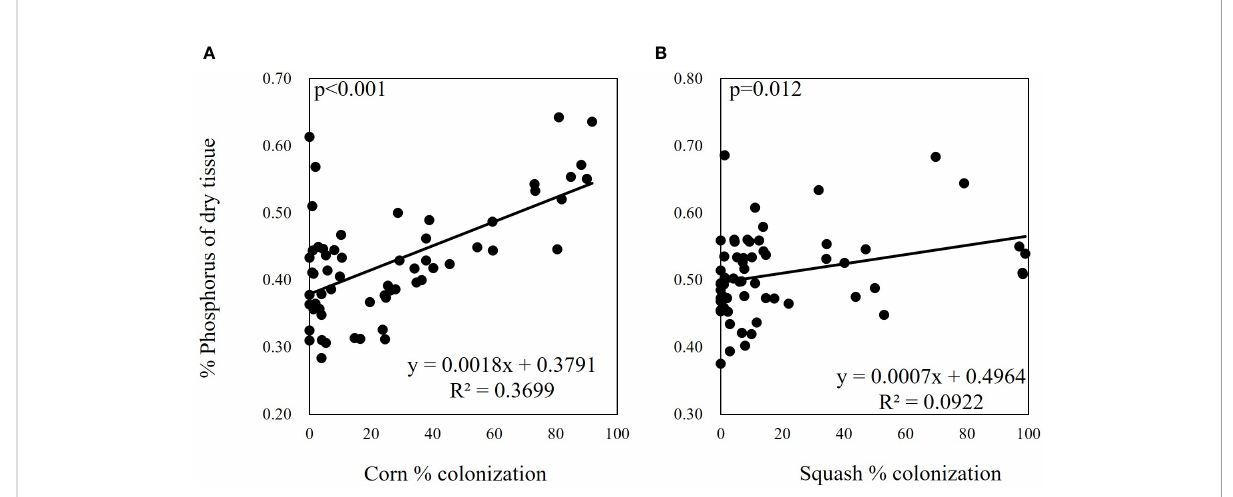
FIGURE 3 Percent root colonization across all seedlings was signi fi cantly correlated with % aboveground tissue phosphorus in corn (A) and squash (B) . P values are from Pearson ’ s product moment correlation. Percent colonization data presented are from the day 30